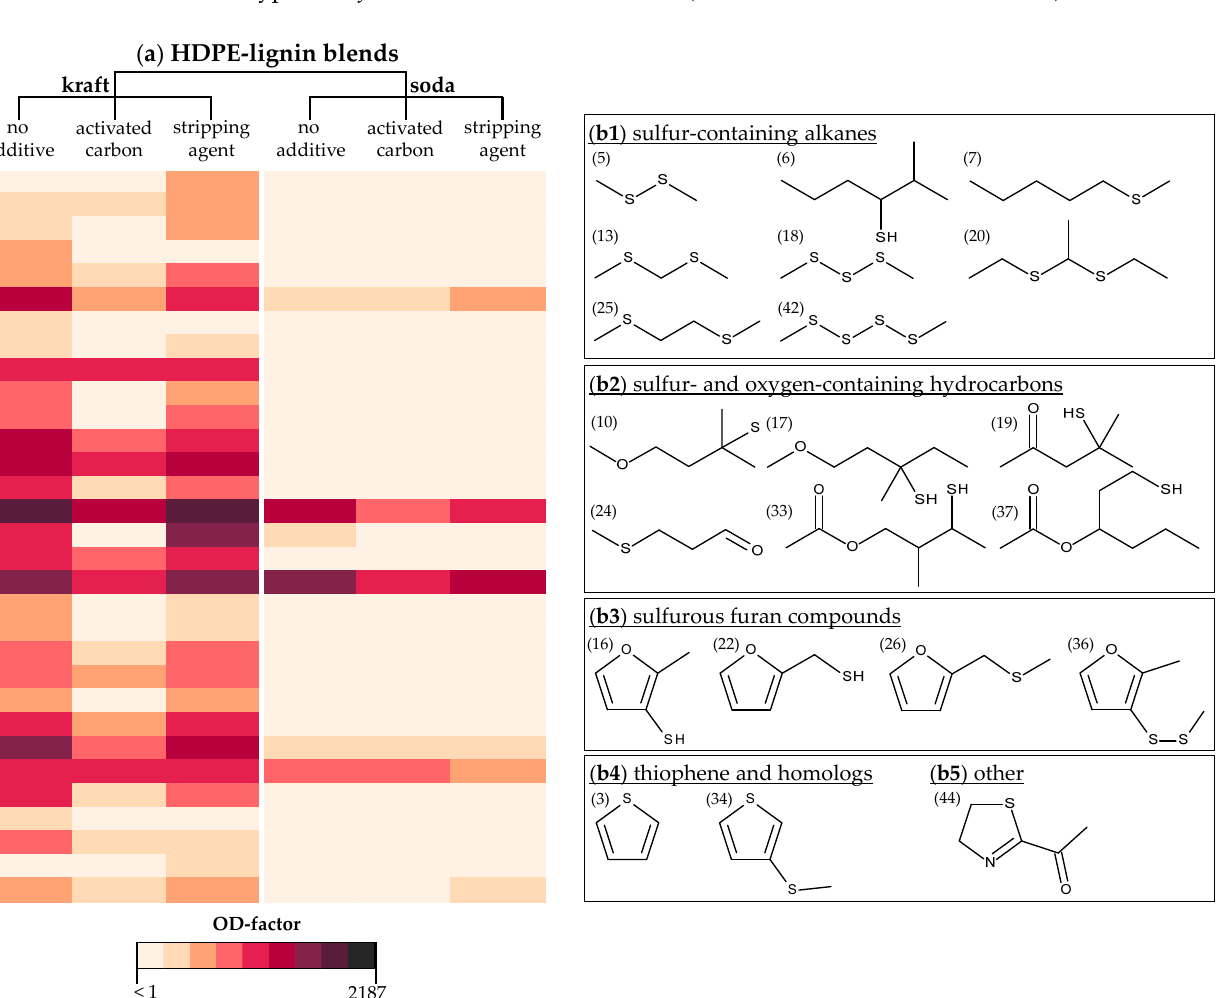
Figure 2. ( a ) Color-illustrated differences in OD-factors of sulfur-containing odorants detected in untreated and treated kraft and soda HDPE-lignin blends and ( b1 – b5 ) structural formulae of sulfur odorants divided into subgroups based on their chemical structure. Numbers (2 − 44) refer to consecutive order of odorants in Table 3.